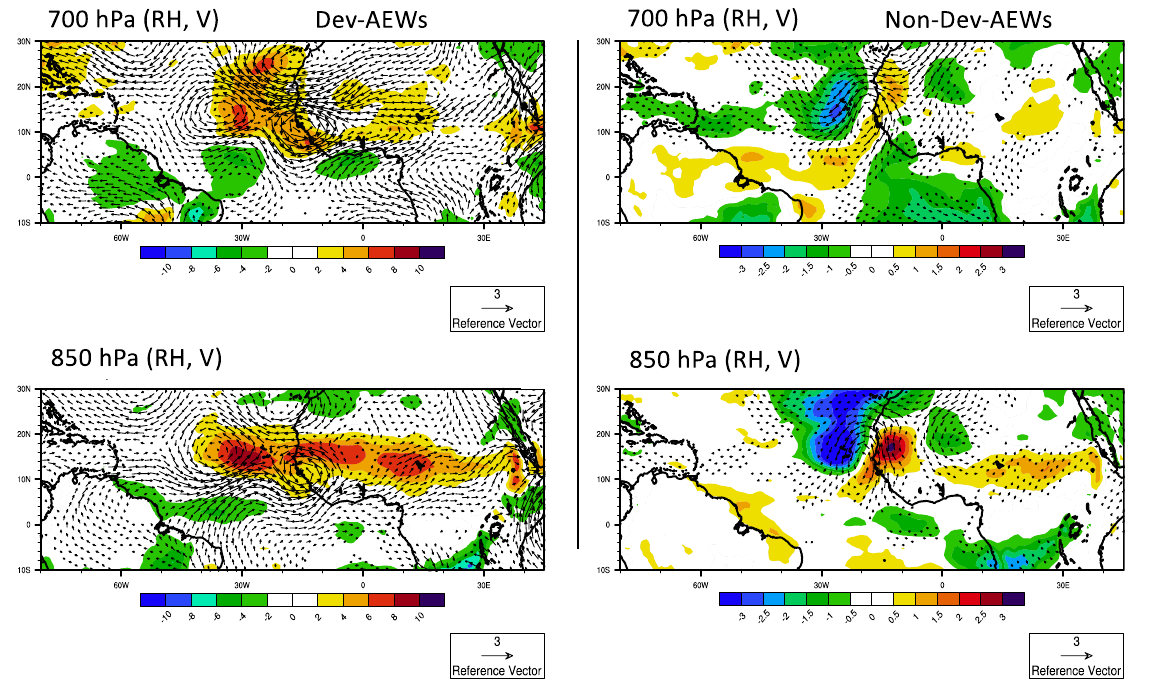
Figure 4. Relative humidity (shaded, in percent) and horizontal wind anomalies at 700 and 850 hPa for developing AEWs ( left panel) and non-developing AEW ( right panel) events. Anomalies are with respect to July–October 1984–2009 climatology. The magnitude of the reference vector is 3 ms − 1 . Wind magnitudes of <0.2 ms − 1 are suppressed for clarity. Note the scale difference in relative humidity for developing and non-developing AEWs.